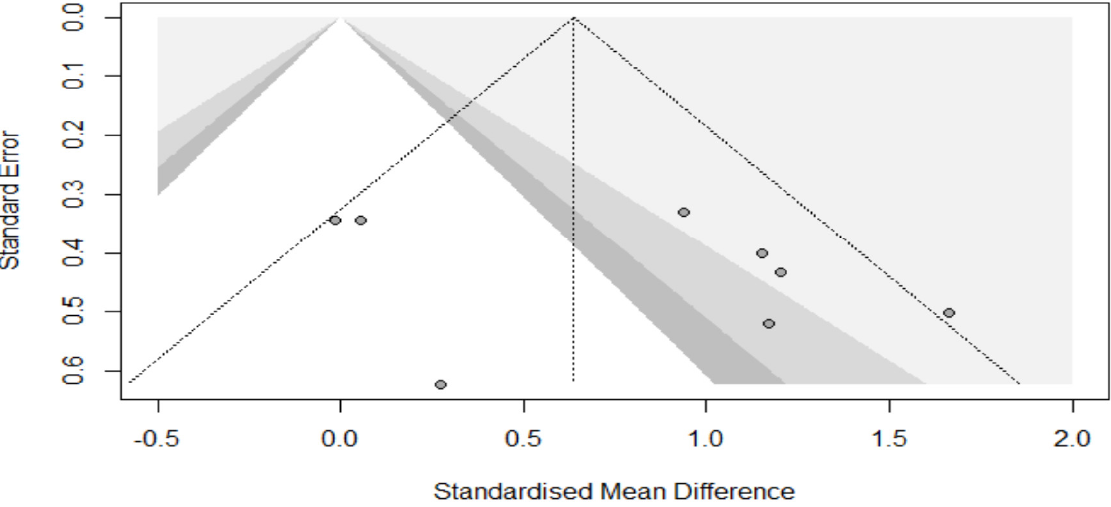
Figure 2. Funnel plot illustrating the symmetrical distribution of the effects across the included studies.